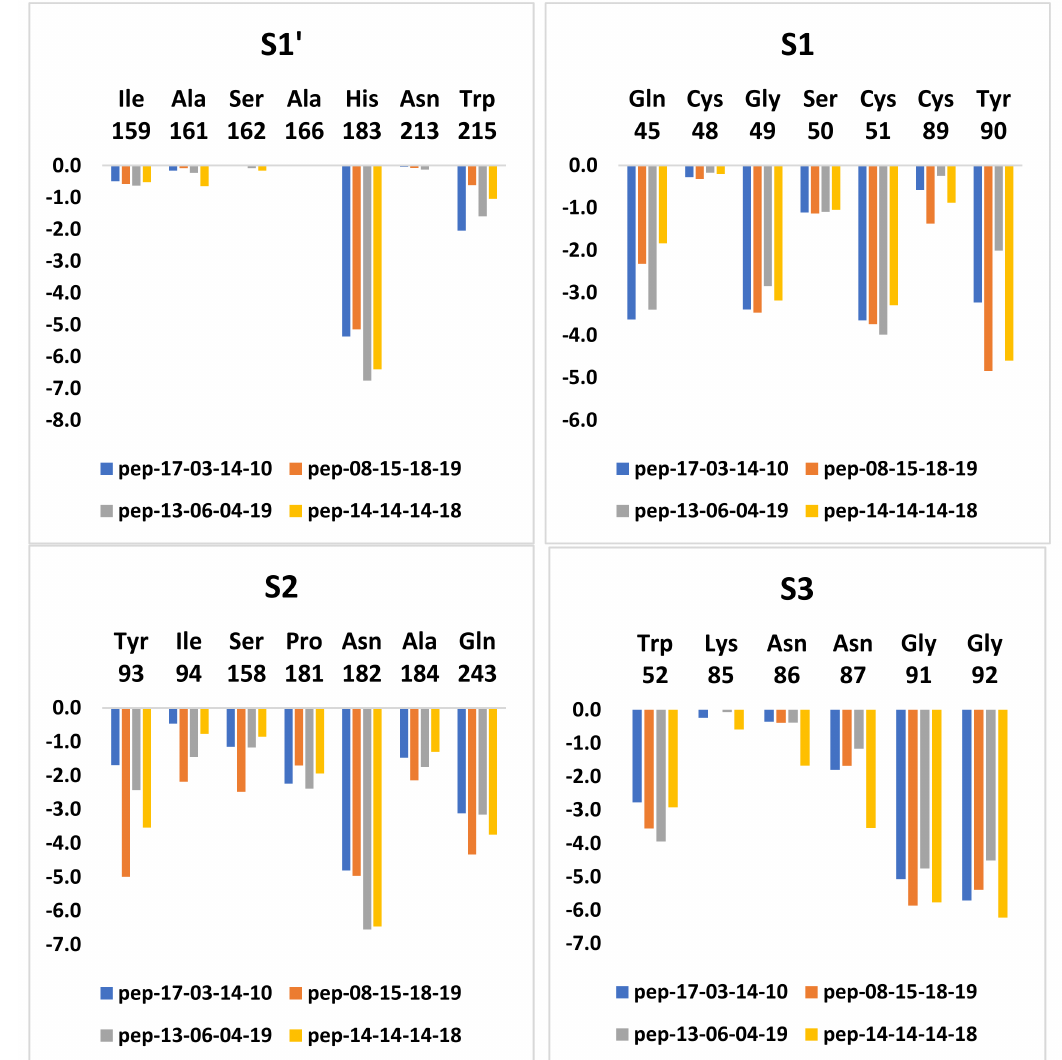
Figure 10. FP3–PEPs interaction energy breakdown for the top four ranked novel